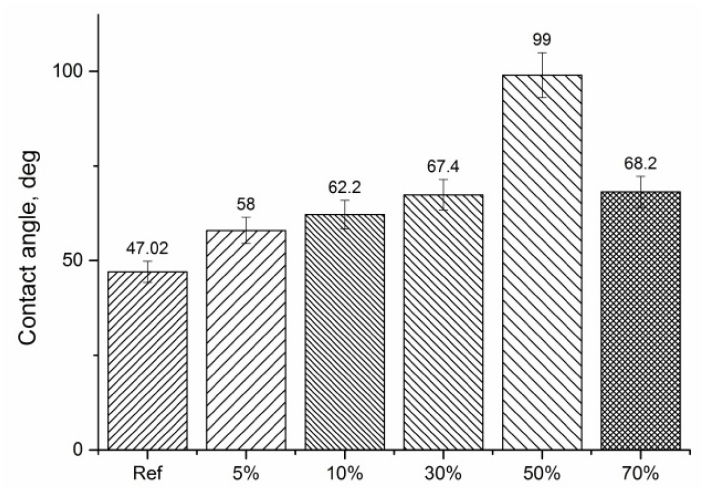
Figure 3. Water contact angle for PLA films with variable OTOA content.